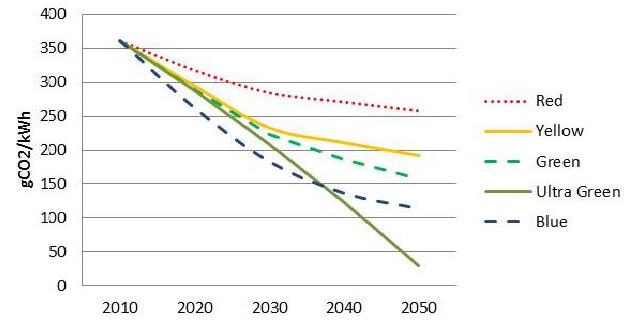
Fig. 7. Development of average specific emissions.